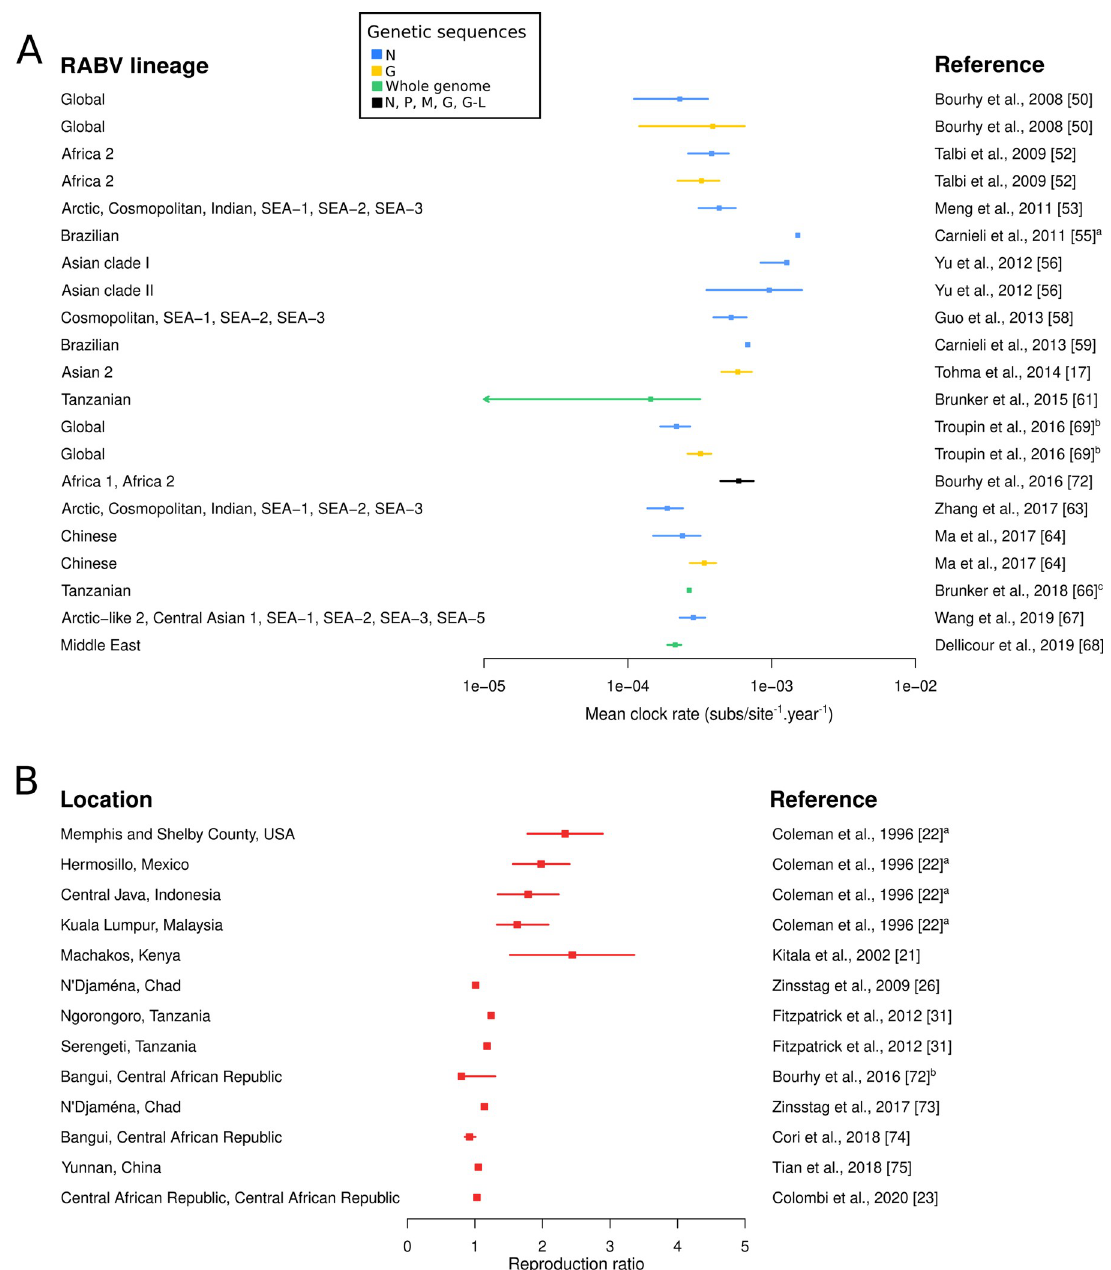
Fig 3. Estimates of the mean evolutionary rate of RABV and the reproduction ratio of canine rabies in the included studies. (A) Bayesian credibility intervals (mean and 95% Highest Posterior Density, HPD) of the mean evolutionary rate of canine RABV per genetic sequence and RABV lineage. a The estimate corresponds to the upper bound of the 95% HPD. b The dot corresponds to the median and the interval to the 95% HPD interval. cThe 95% HPD was not specified in the original publication. (B) Estimates of the reproduction ratio of dog rabies per control strategy or geographical location. The dot corresponds to the mean and the interval to the 95% confidence interval unless stated otherwise. a The interval corresponds to the standard error. b The authors estimated the effective reproduction ratio along time. Here, the value range of the median monthly point estimate is